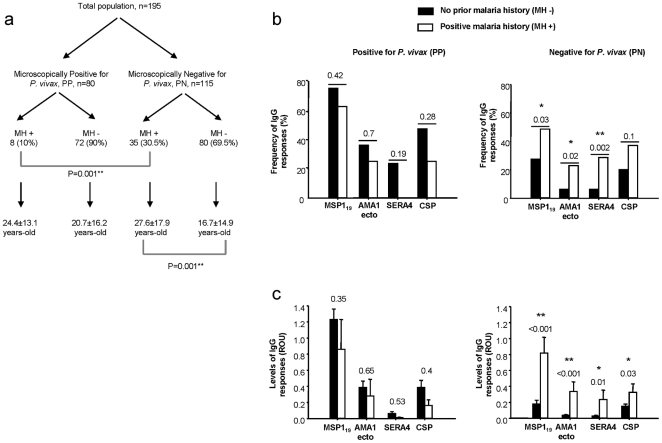
Impact of malaria infection history on naturally acquired antibody responses against P. vivax antigens.
(a) Malaria infection history (MH) and its relationship to age. The total population was categorized according to blood smear positive (PP) and negative (PN) status for P. vivax, and then according to malaria infection history and age. The frequency (percentage seropositivity) (b) and serum antibody levels (ROU) (c) of the total IgG responses against the four antigens are depicted. The χ2 test was used to compare the frequencies and mean ages between groups (a). Bars (c) represent the mean±SEM, and ROU levels were compared using multiple comparison analysis in conjunction with ANOVA (*P<0.05 and **P<0.01).